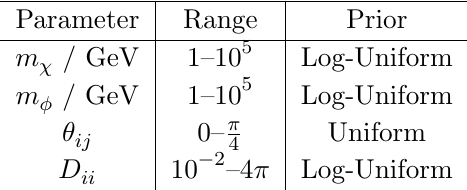
Table 4 . Allowed ranges for the parameters used in the MCMC scan, along with the assumed prior likelihood, which is uniform on either a linear or logarithmic